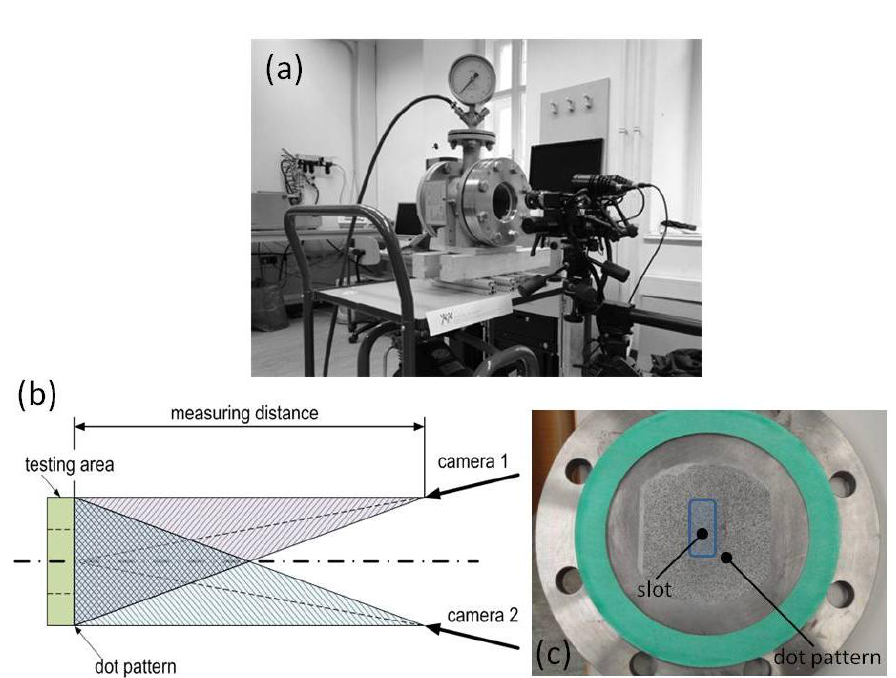
Figure 8. ( a ) In-house developed pressure chamber; ( b ) Scheme of the measurement setup for the 3D-image correlation with Aramis (GOM); ( c ) Testing plate with 30 mm slot and dot